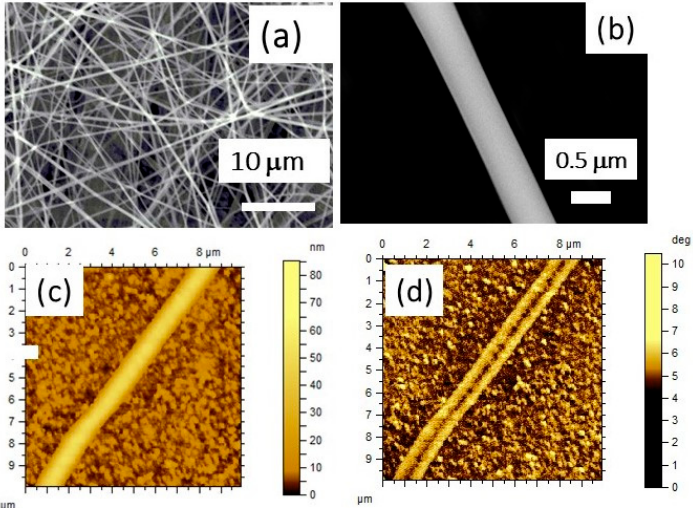
Figure 1. Scanning electron microscopy (SEM) micrograph of ( a ) coaxial fibers of sample A with barium titanate (BTO) core and nickel ferrite (NFO) shell and ( b ) a single fiber of sample A. ( c ) Atomic force microscopy (AFM) topography for fibers of sample B with NFO core–BTO shell. ( d ) Magnetic force microscopy (MFM) phase image for sample B.